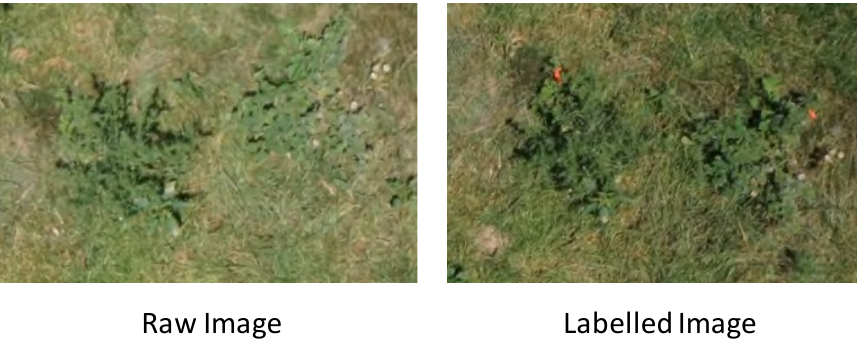
Figure 6. Two flights were performed at the tropical soda apple sites. The first flight was used to collect the raw image data for algorithm evaluation ( left ) and the second flight to identify the tropical soda apple plants, which had been marked by weed experts ( right